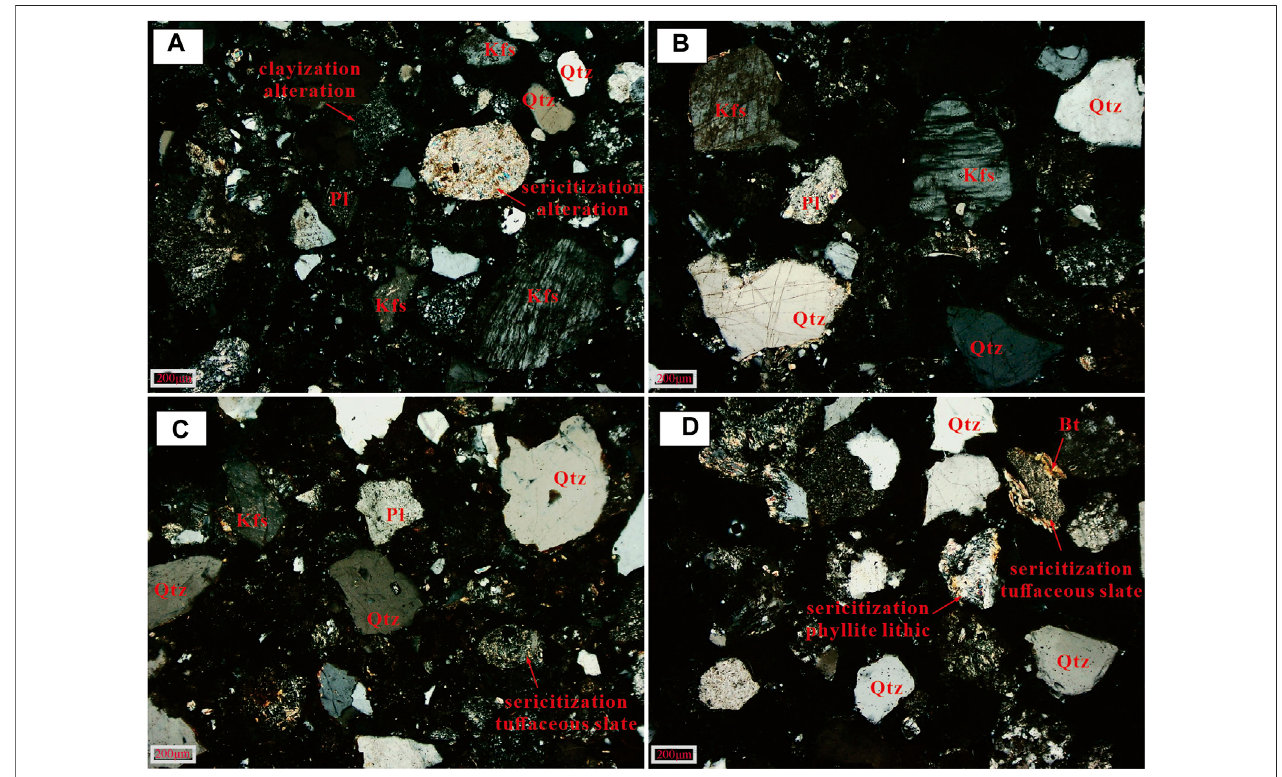
FIGURE6| ThinsectionphotomicrographsofthesamplesofTongheT3 fl uvialterrace(Qtz=quartz;Kfs=K-feldspar;Pl=plagioclase;Bt=biotite).Notethatboth K-feldspar and plagioclase show sericitization and clayization alteration to varying degrees, and the edge of quartz shows dissolution